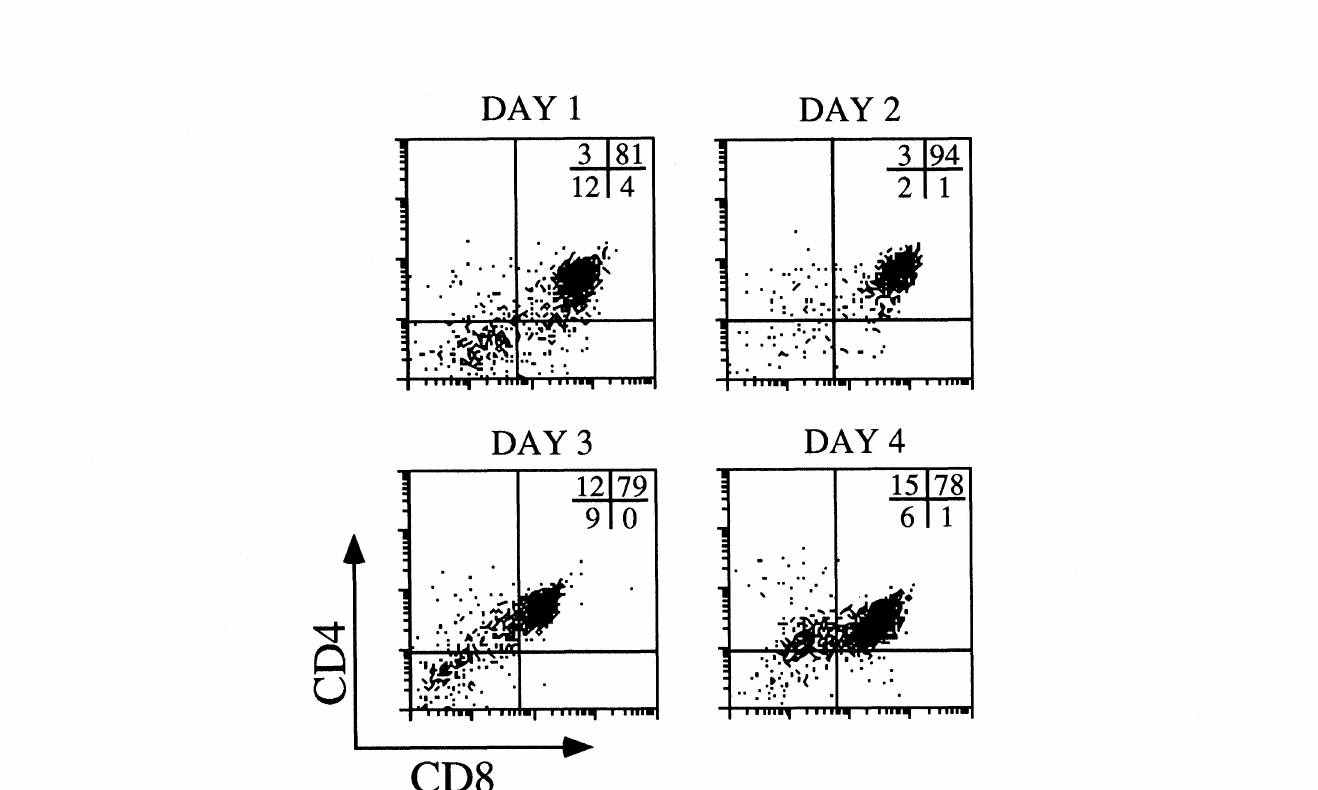
FIGURE 6 Kinetics of transgenic cells cultured alone show that cells do not differentiate beyond the double-positive stage of development. El7 transgenic thymocytes from a nonselecting background were cultured alone over a 4-day period and analyzed daily for CD4 and CD8